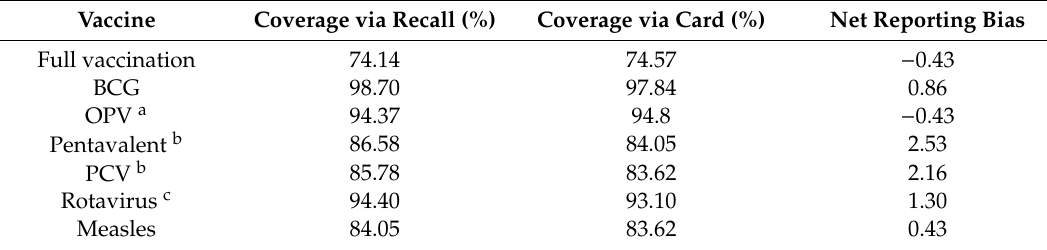
Table 3. Vaccination coverage via recall and card and net reporting bias.